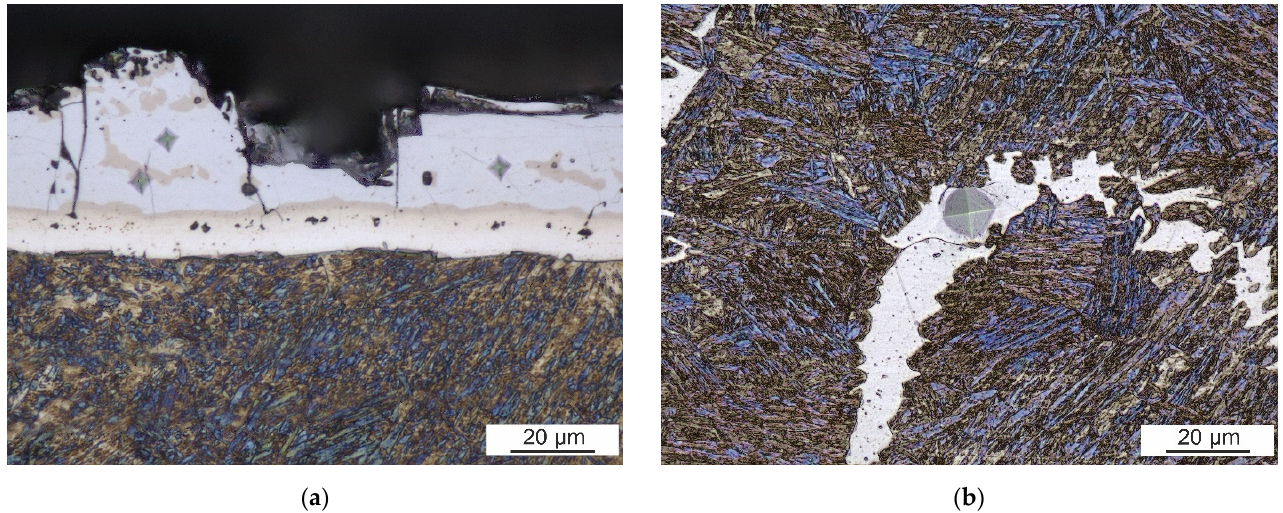
Figure 12. Microindents ( a ) in the surface coating and ( b ) in the ferritic region of FZ of a laser weld.